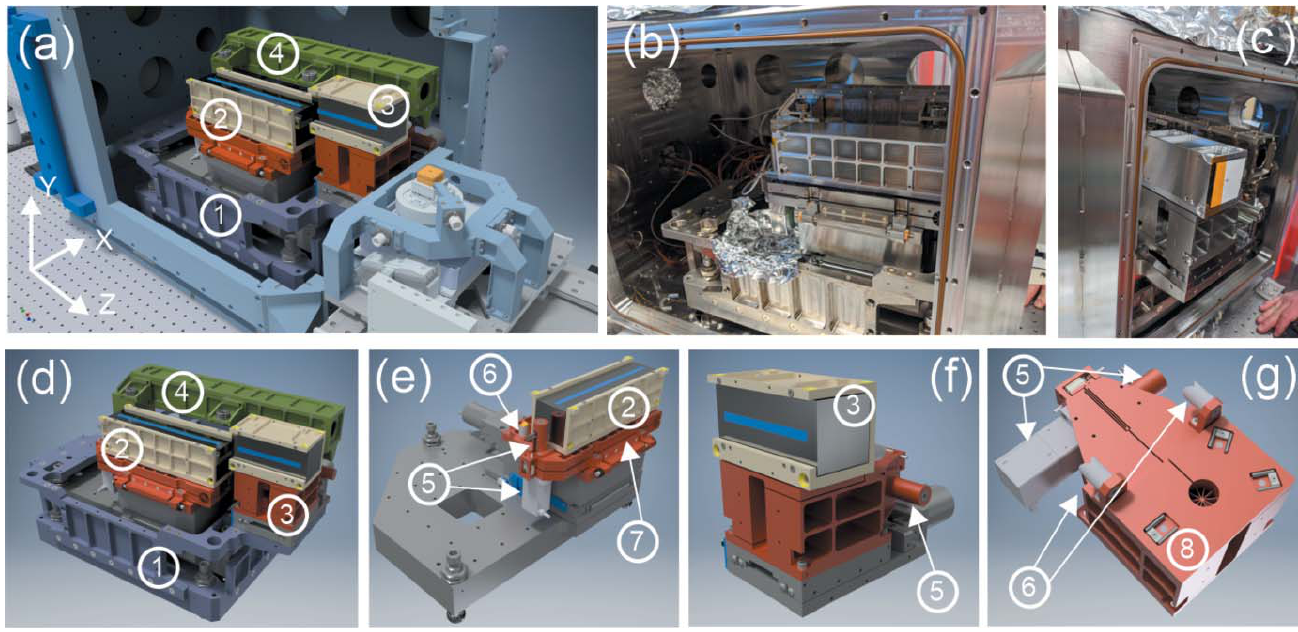
Figure 4 Overview of the KB manipulation system. Panels ( a ), ( d ), ( e ), ( f ), and ( g ) represent CAD models of various components. 1 – Invar base supporting both vertical and horizontal KB mirrors; 2 – vertical KB mirror assembly; 3 – horizontal KB mirror assembly; 4 – Invar reference frame for laser interferometer heads used to monitor/encode the position of the mirrors; 5 – coarse and fine actuators used to angularly align both mirrors; 6 – retroreflectors used in conjunction with the laser interferometer heads; 7 – flexure for the vertical KB mirror; 8 – flexure for the horizontal KB mirror. Panels ( b ) and ( c ) are the photographs of the installed system.